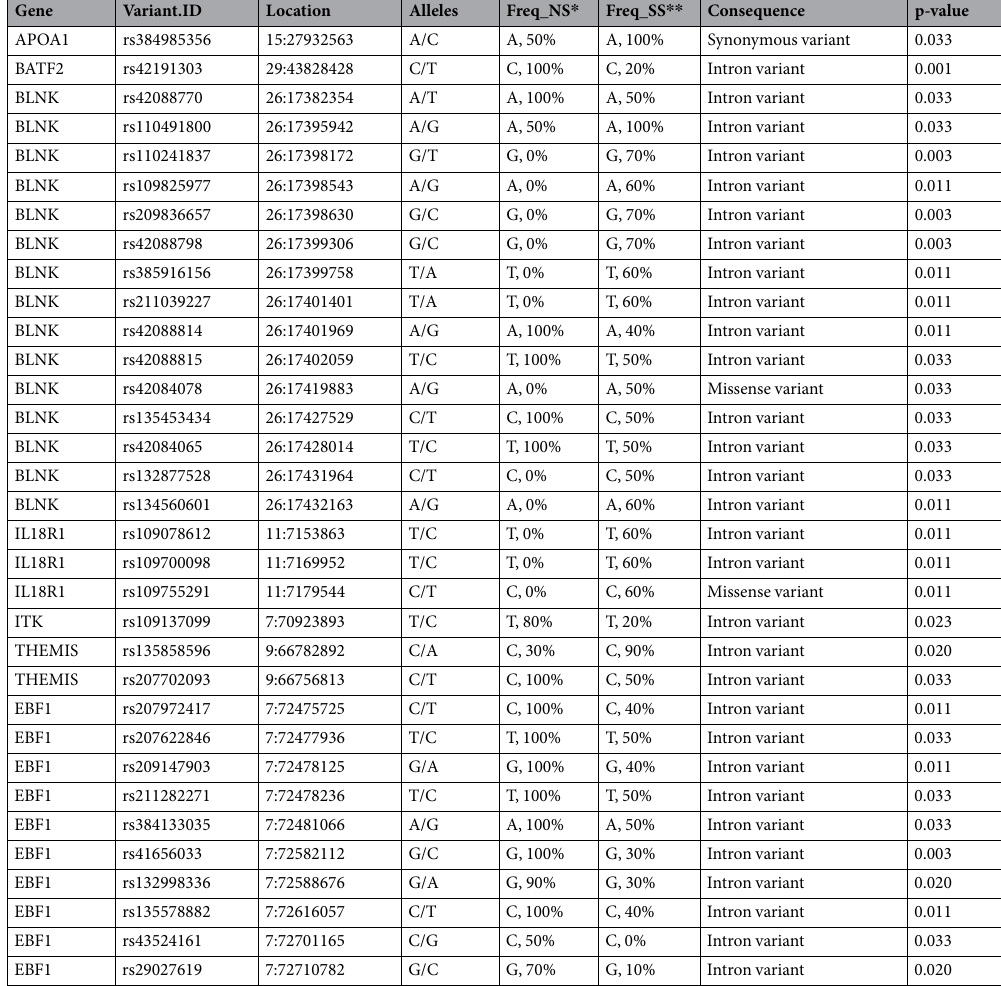
Table 4. SNPs which showed association with super-shedding phenomena. * Allele frequency in non-shedders, total frequency of two alleles are 100%. ** Allele frequency in super-shedders, total frequency of two alleles are